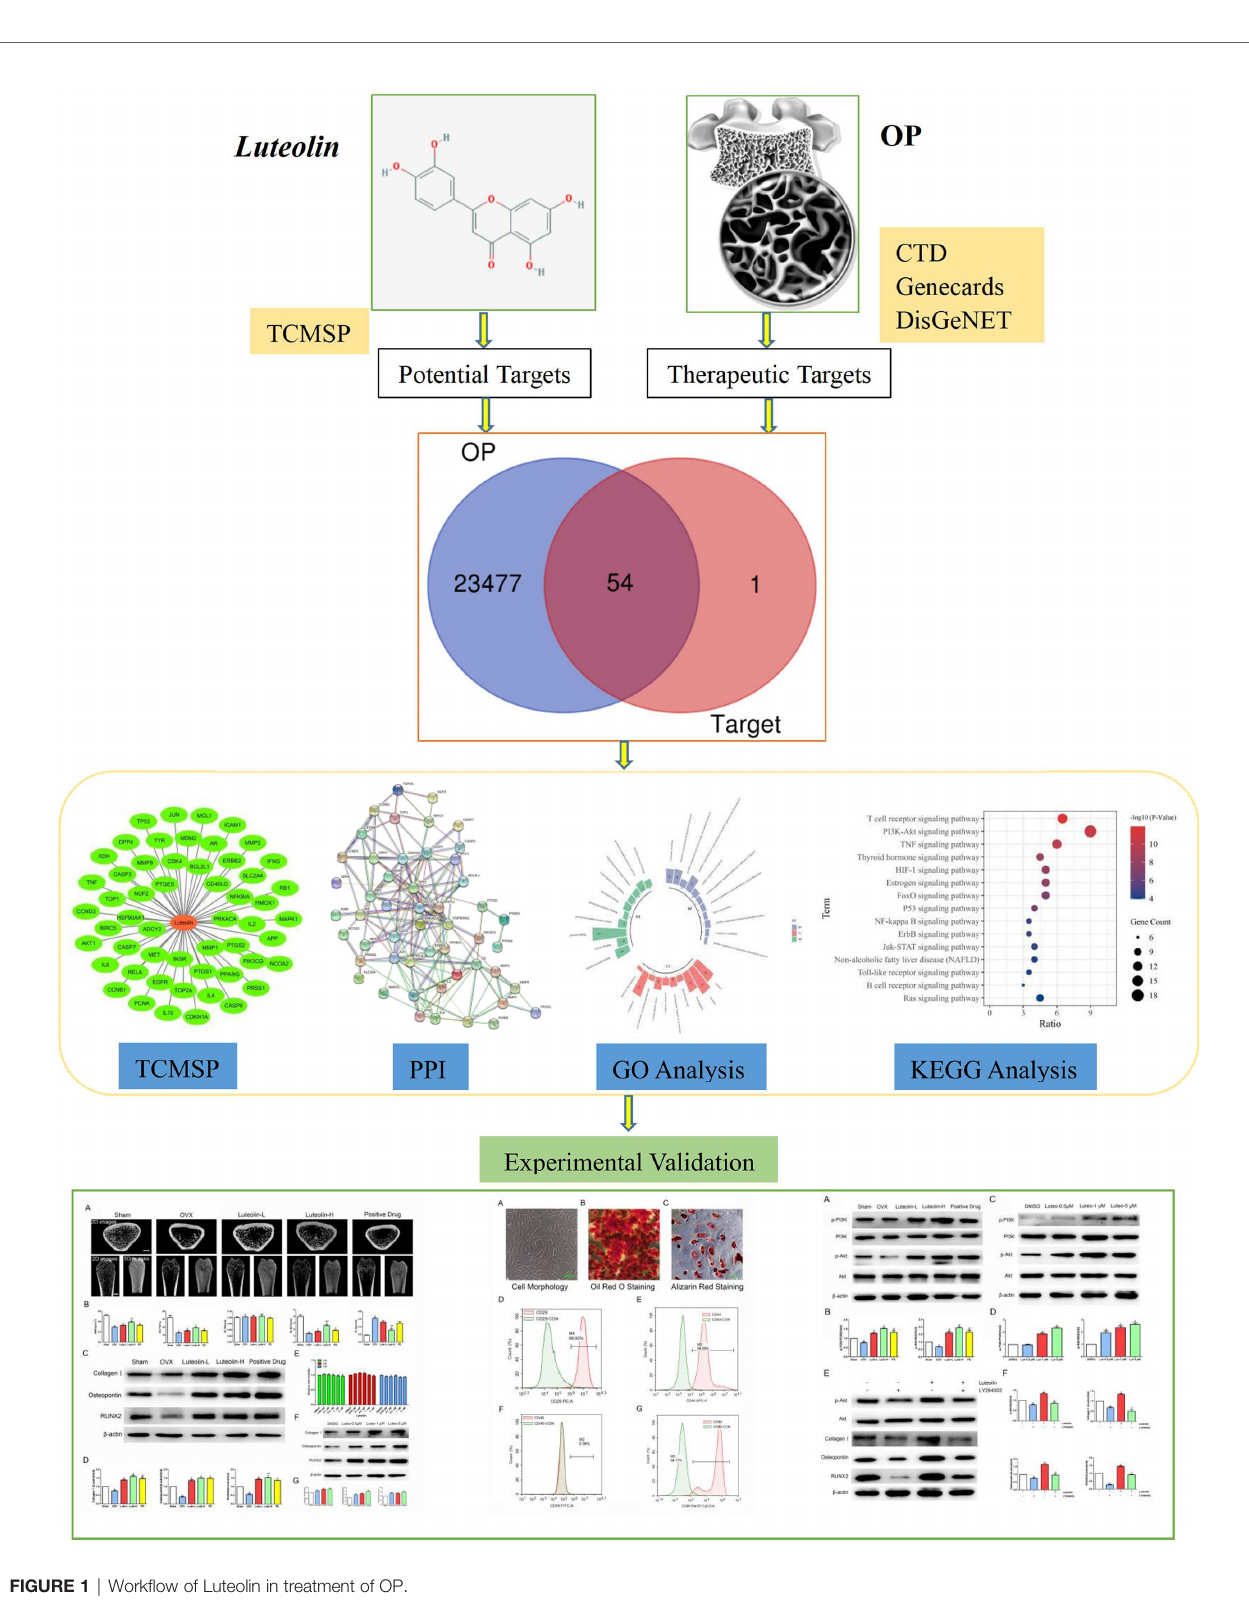
FIGURE 1 | Work fl ow of Luteolin in treatment of